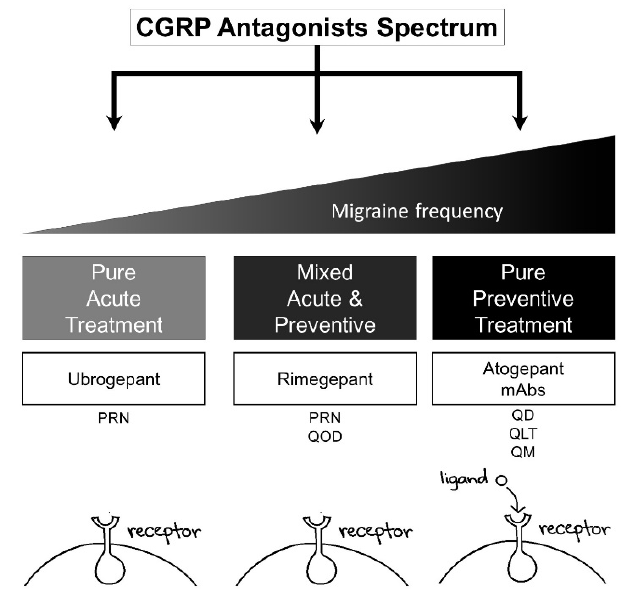
Figure 3. Spectrum of calcitonin gene-related peptide (CGRP) medications in clinical practice. The increase in migraine frequency per month is related to preventive therapy. Apparently, treatment is associated with a drug target that could be a receptor or ligand. Receptor target: erenumab, ubro- gepant, rimegepant, and atogepant. Ligand target: fremanezumab, galcanezumab, and